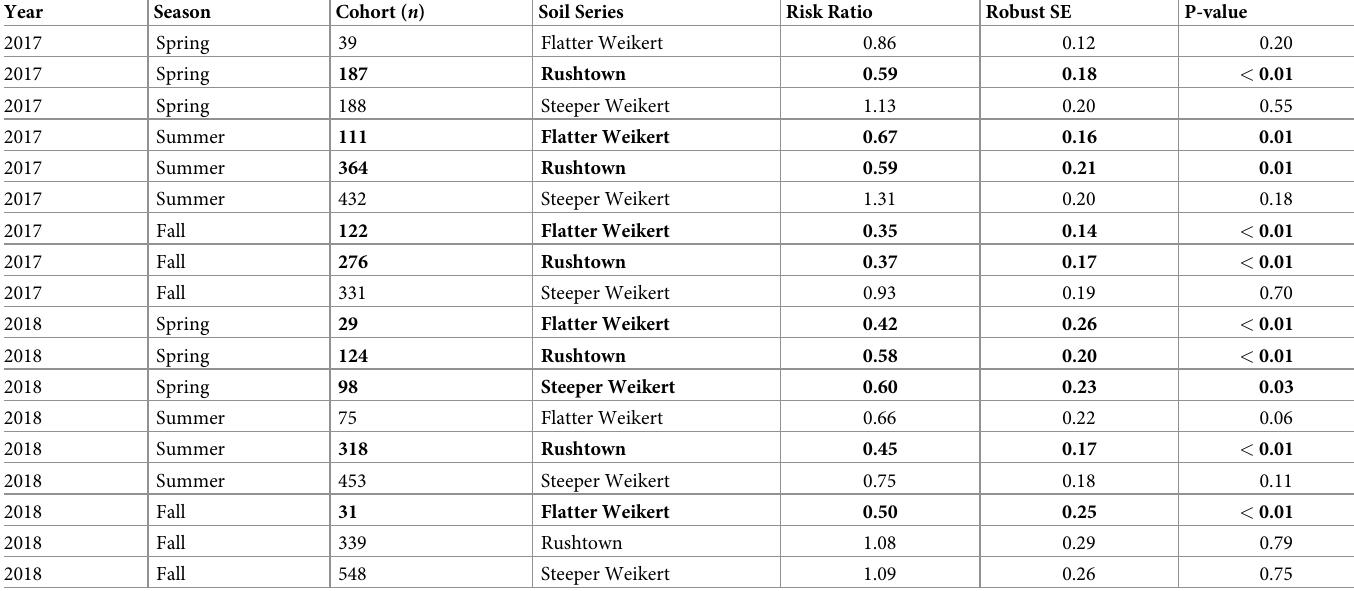
Table 2. Mid-slope soil series proportional hazards table for different years and seasons.